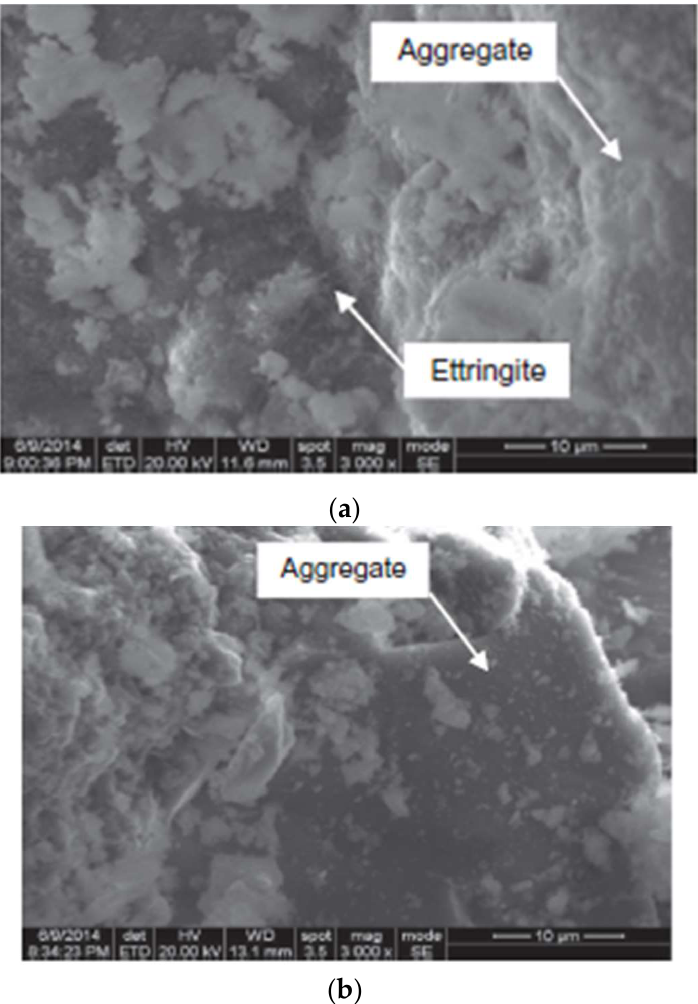
Figure 3. SEM image of ( a ) uncarbonated RCA; ( b ) carbonated RCA [35]. Reproduced with permission from [35], Elsevier, 2015.